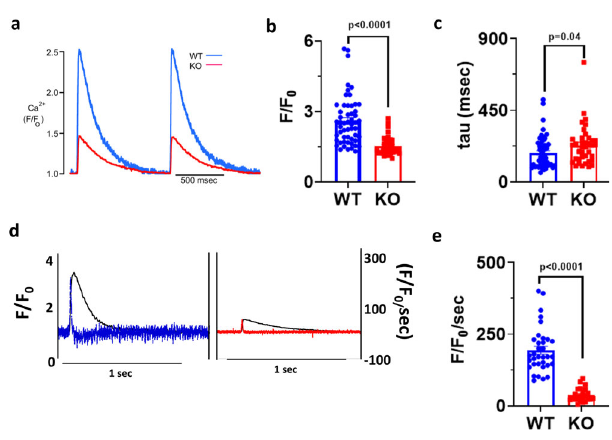
Fig. 3 Impaired calcium cycling in VDAC2-KO cardiomyocytes. a Representative calcium transient image of 16-week-old mice (Time frame, 500 ms); b Amplitude ( F / F 0 ) data ( p < 0.0001) (WT n = 54, KO n = 38, N = 3); c Rate of calcium uptake (tau) (ms) ( p = 0.0492) (WT n = 54, KO n = 38, N = 3); d Representative image of rate of calcium release of 16- week-old mice (Time frame, 1 s); e Rate of calcium release ( F / F 0 /s) ( p < 0.0001) (WT n = 34, KO n = 23, N = 3). p -value: unpaired two-tailed t -test performed in all comparisons. Data are represented as mean ±